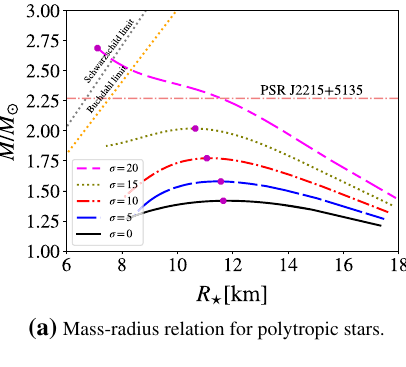
( a ) Mass-radius relation for polytropic stars.